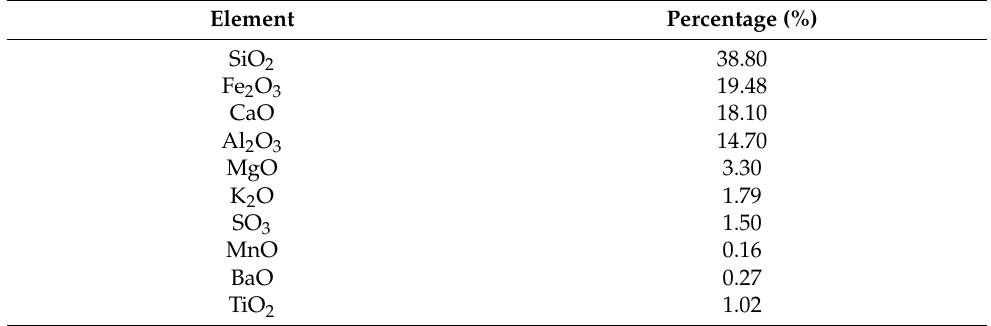
Table 4. Chemical composition of fly ash.